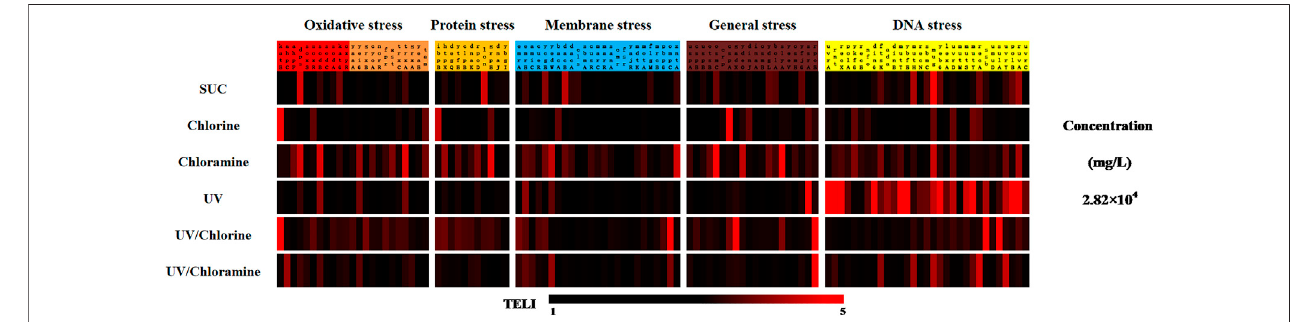
FIGURE 11 | TELI for each change in gene response to SUC exposure and different disinfection processes.